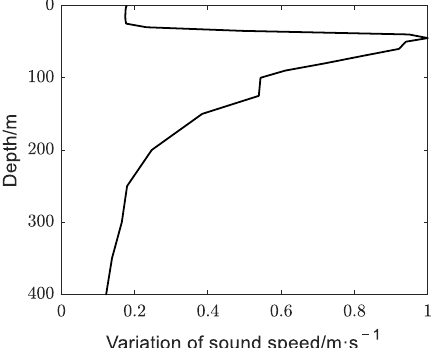
Figure 1. Sound speed profile with linear variation.